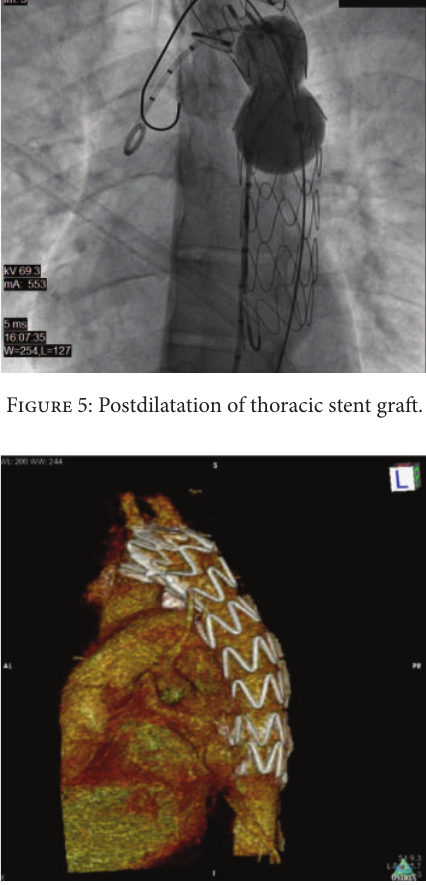
Figure 6: Thorax CT angiography showed good apposition of thoracic stent graft with complete exclusion of